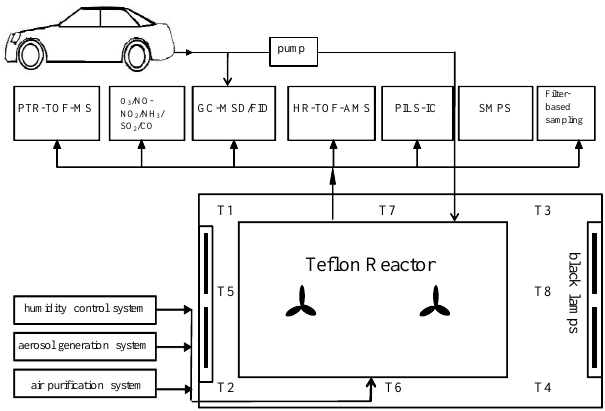
Figure 1. Schematic of the GIG-CAS smog chamber facility and vehicle exhaust injection